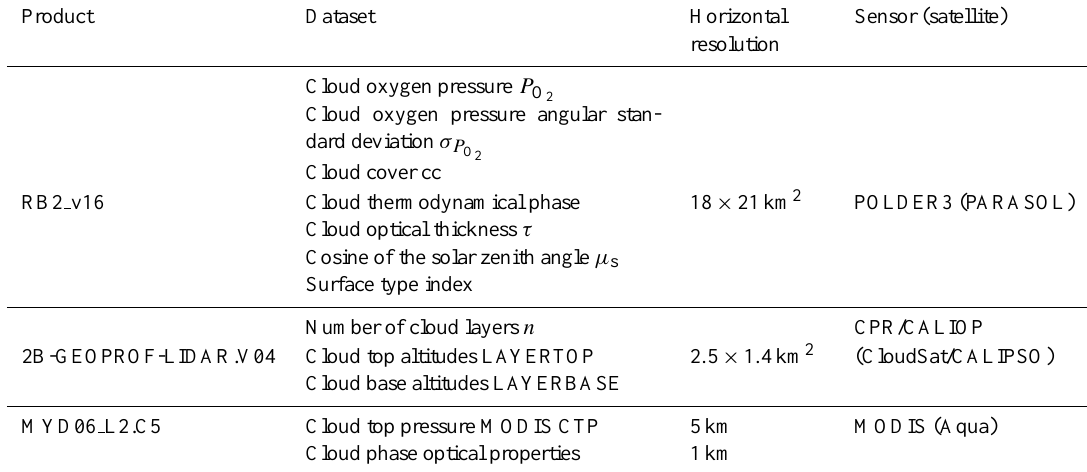
Table 1. Level 2 A-Train data (daytime only) used in this study collocated with lidar shots sampled at